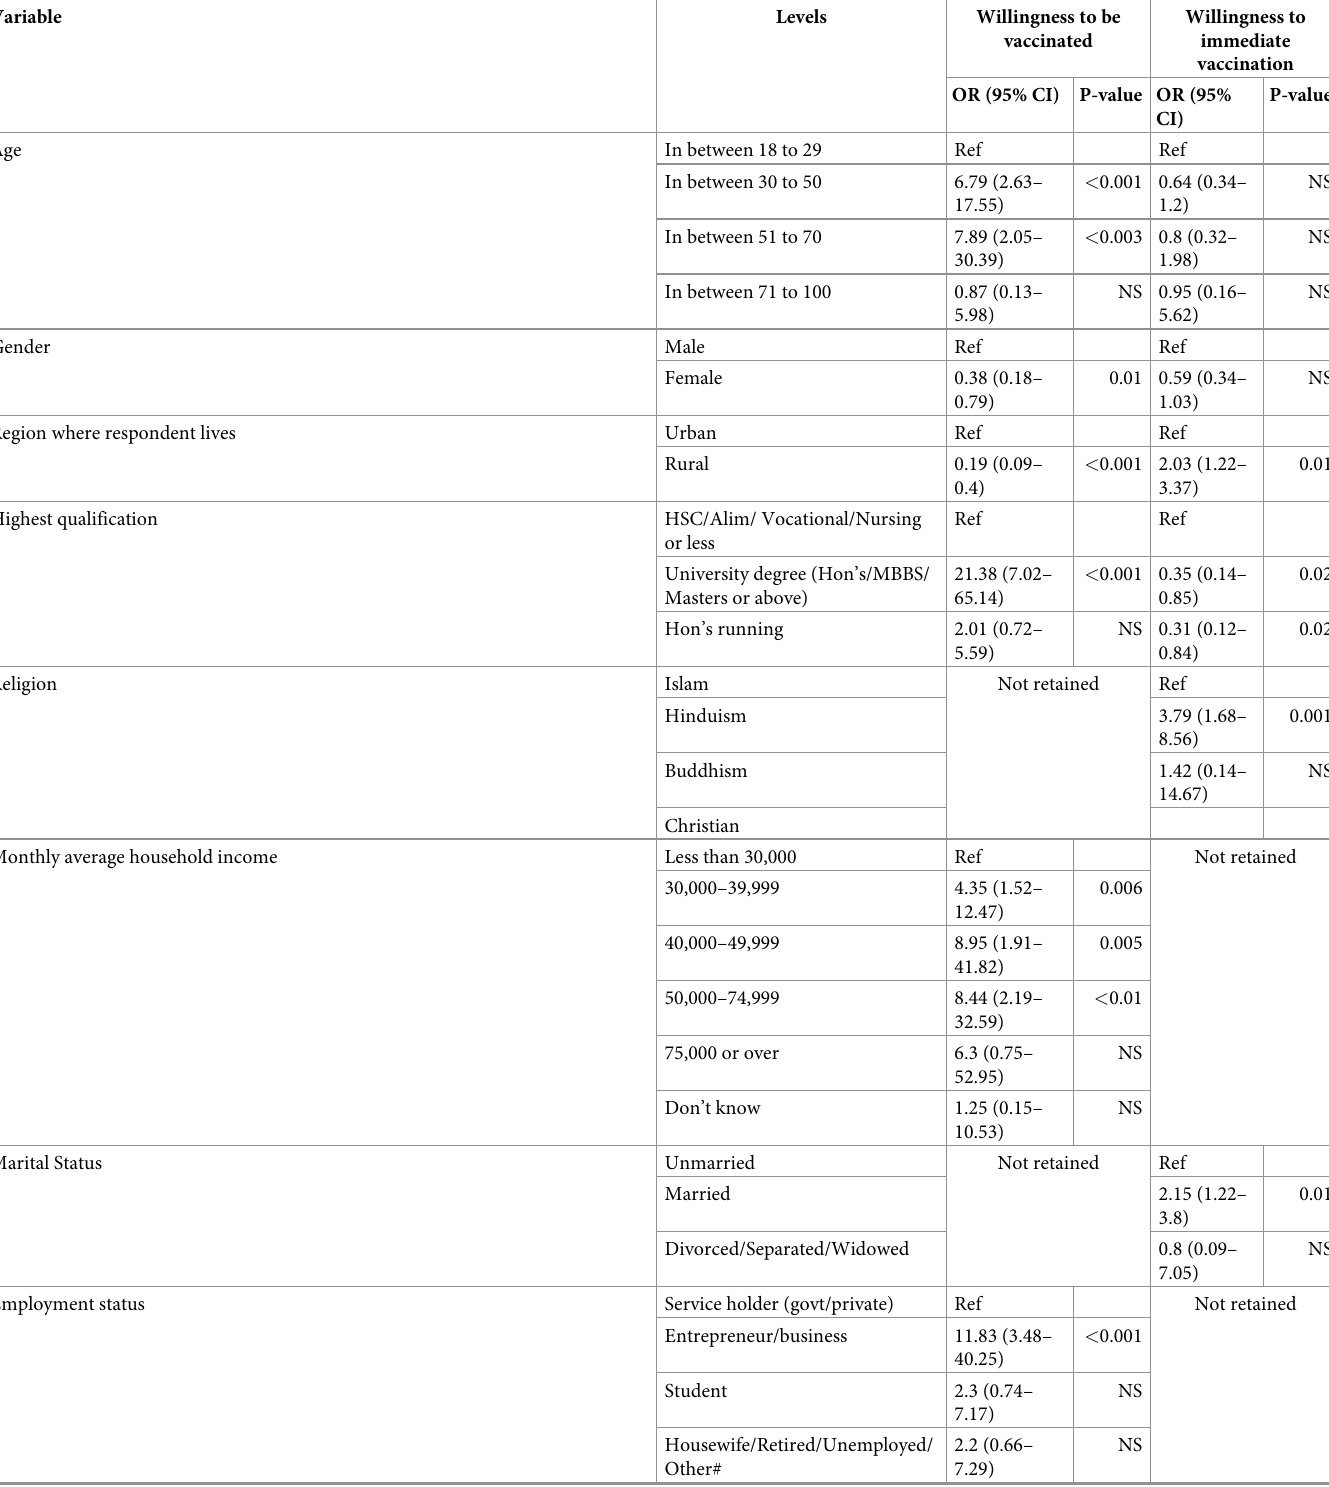
Table 3. Results of the multivariate logistic regressions analyzing the associations with acceptance of vaccination and acceptance of immediate